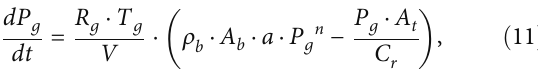
the right side of the fi gure, and H axis on the left side of the fi gure), at the 30th second, drift fault, d equal before the fault occurs ( H